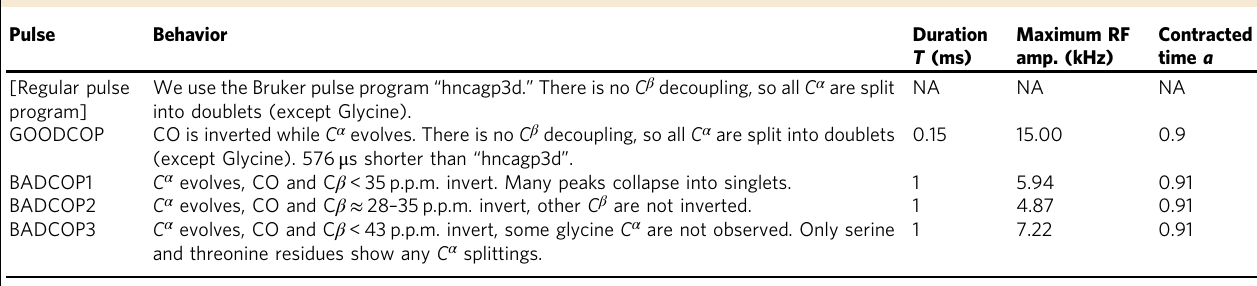
Table 1 C α decoupling pulses for the HNCA